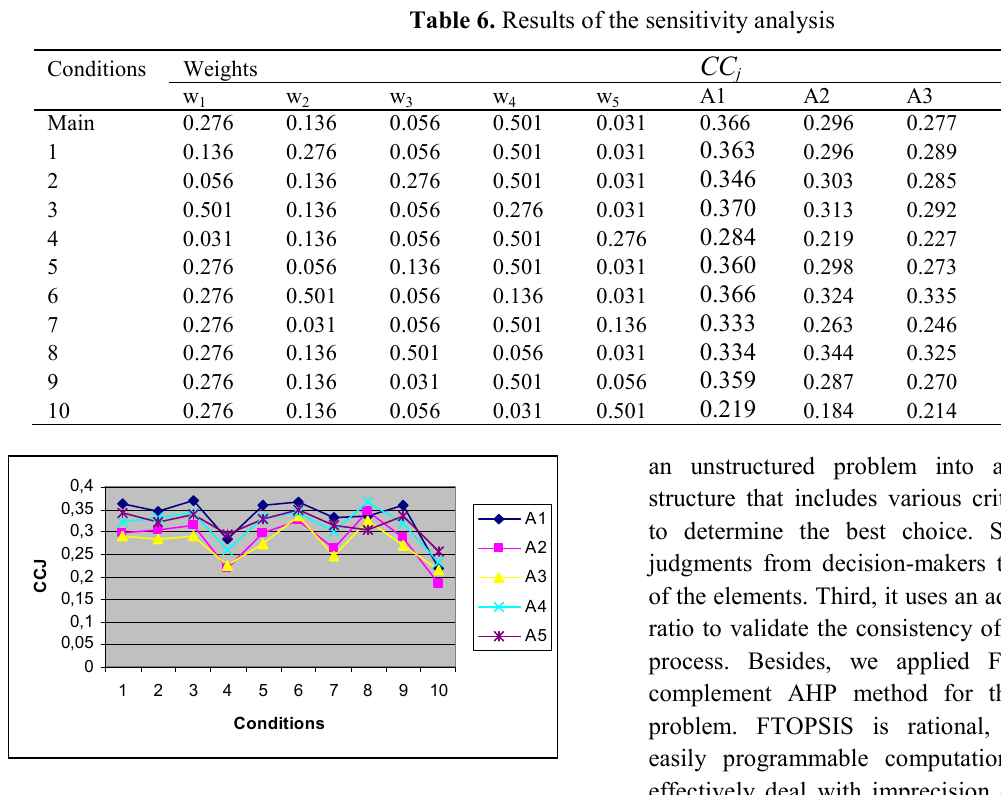
Fig. 1. Sensitivity analysis